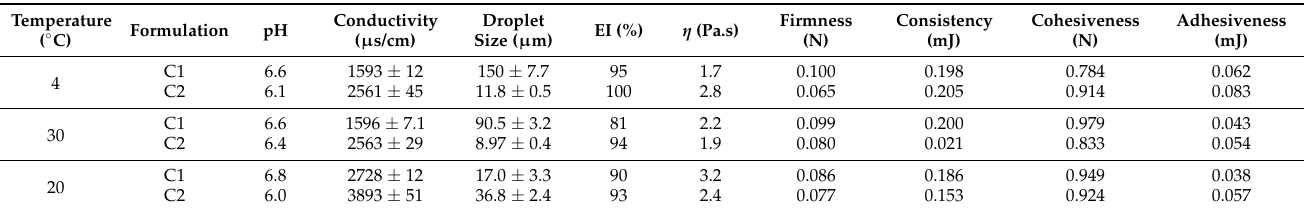
Table 4. Physicochemical characterization of formulation C1 and C2 during 45 days of storage at 4 ◦ C, and 30 ◦ C. η at 2.30 s − 1